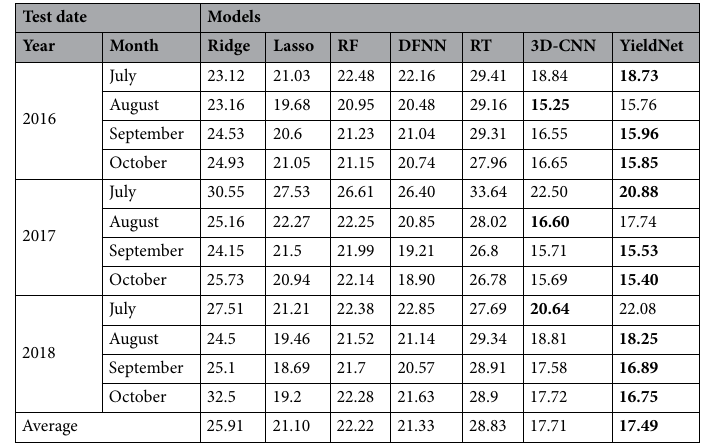
Table 4. The RMSE of corn yield prediction performance of models. The average ± standard deviation for corn yield in years 2016, 2017, and 2018 are, respectively, 165.72 ± 30.35 , 168.50 ± 32.88 , and 170.77 ± 34.95 . The numbers of test samples in years 2016, 2017, 2018 for corn yield prediction are 885, 882, and 784, respectively. The unit of RMSE is bushels per acre. Best results are given in bold.